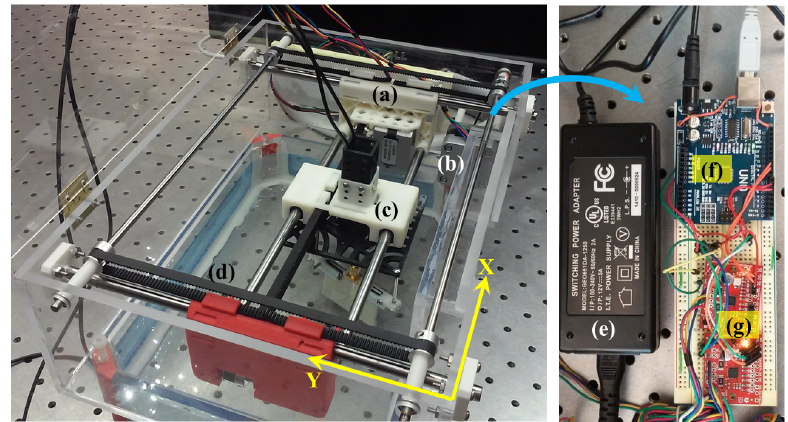
Figure 6. Mechatronic System: ( a ) Sliding motor and its holder, ( b ) fixed motor, ( c ) antenna holder,